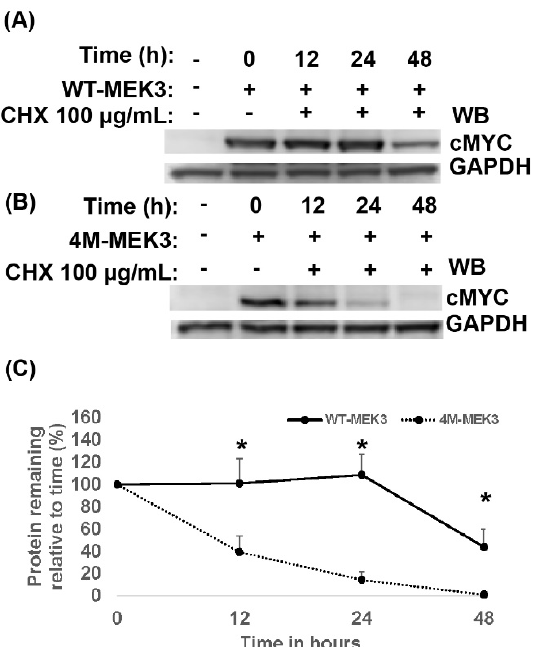
Figure 4. Quadruple MEK3 mutant was degraded at an accelerated rate compared to wild type. HEK293 cells were not transfected ( − ) or transiently transfected with ( A ) WT-cMYC or ( B ) 4M-MEK3-cMYC mutant construct. Twenty-four hours post-transfection, cells were left untreated (−) or treated with CHX (+) for the indicated time points. Cell lysates were collected and separated by SDS-PAGE and immunoblotted (WB), as indicated. ( C ) Quantified protein expression of WT-MEK3 or 4M-MEK3 is shown relative to time 0. Band intensities were normalized to GAPDH using densitometric analysis and presented as a ratio of cMYC to GAPDH. Data are presented as mean ± SEM ( n = 3). A t-test (unpaired) was used to determine statistical significance. *, p < 0.05.